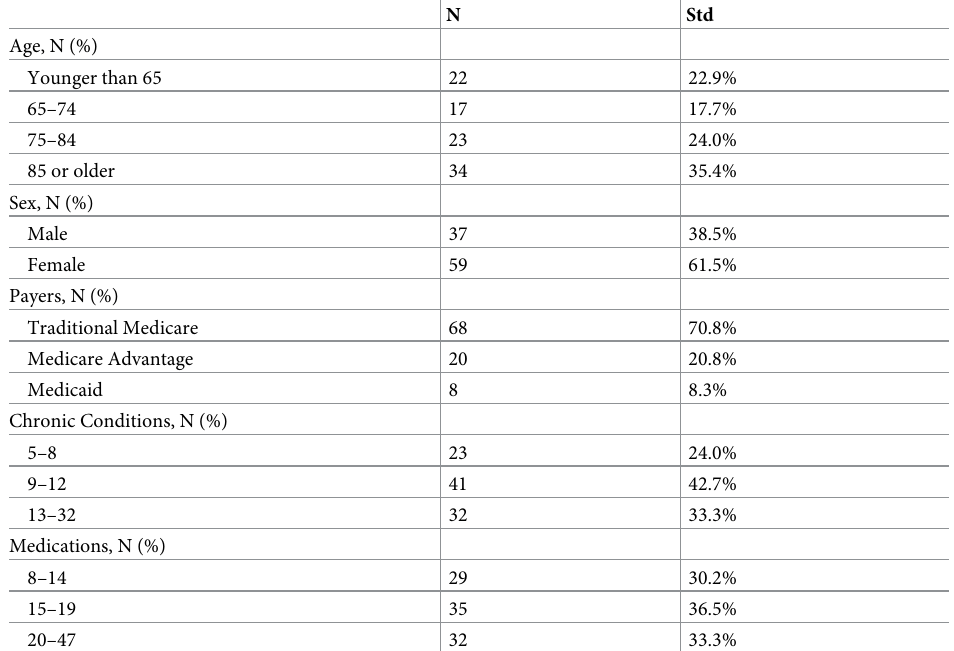
Table 3 describes three examples of pharmacist recommendations that were accepted. In the first example, a 79-year-old patient on eltrombopag required medication dose adjustment based on their lab results to prevent potential thromboembolism; the second accepted recom-